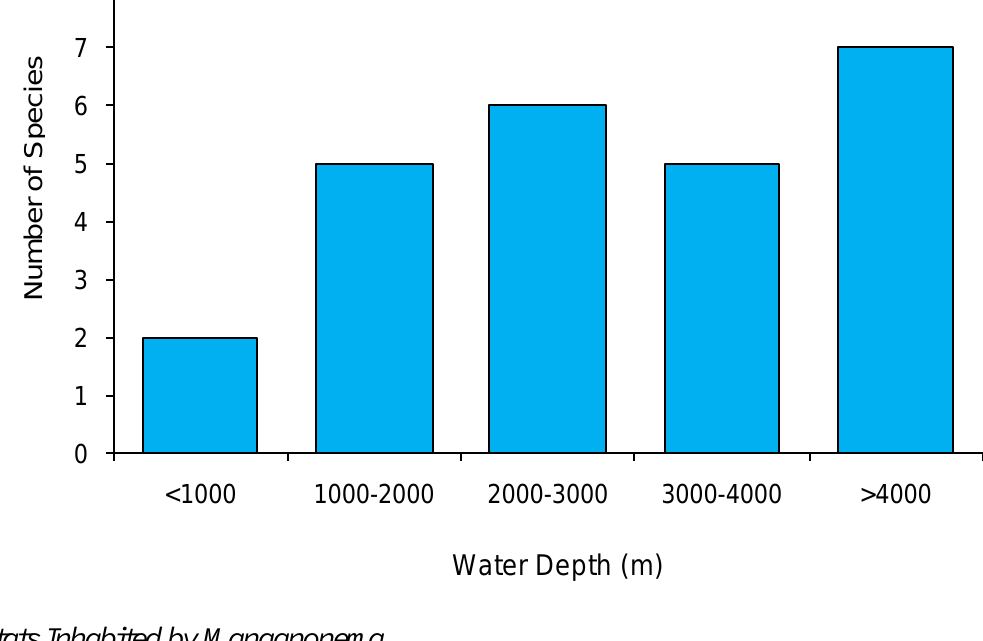
Figure 2. Bathymetric species richness of the genus